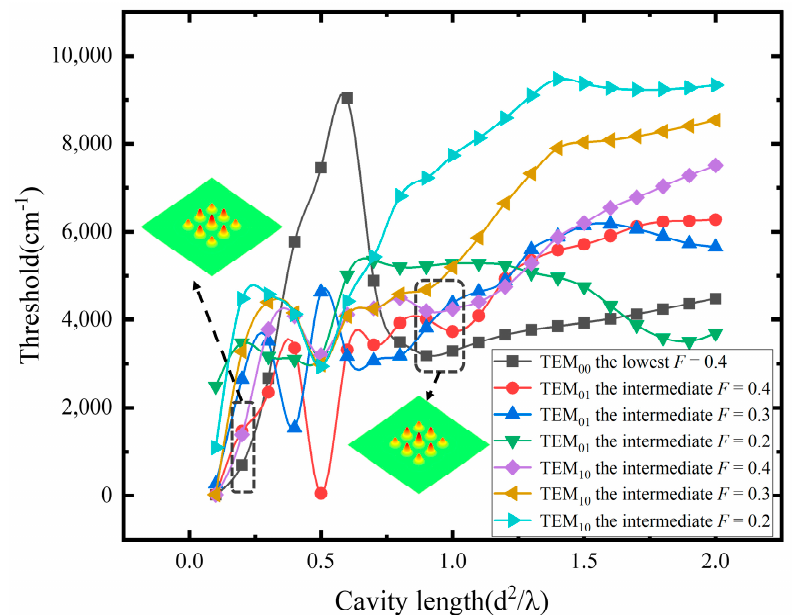
Figure 7. The curves of the minimum thresholds among supermodes of the high-order transverse mode (TEM 01 and TEM 10 ) array which may be generated with the different duty ratio F and the